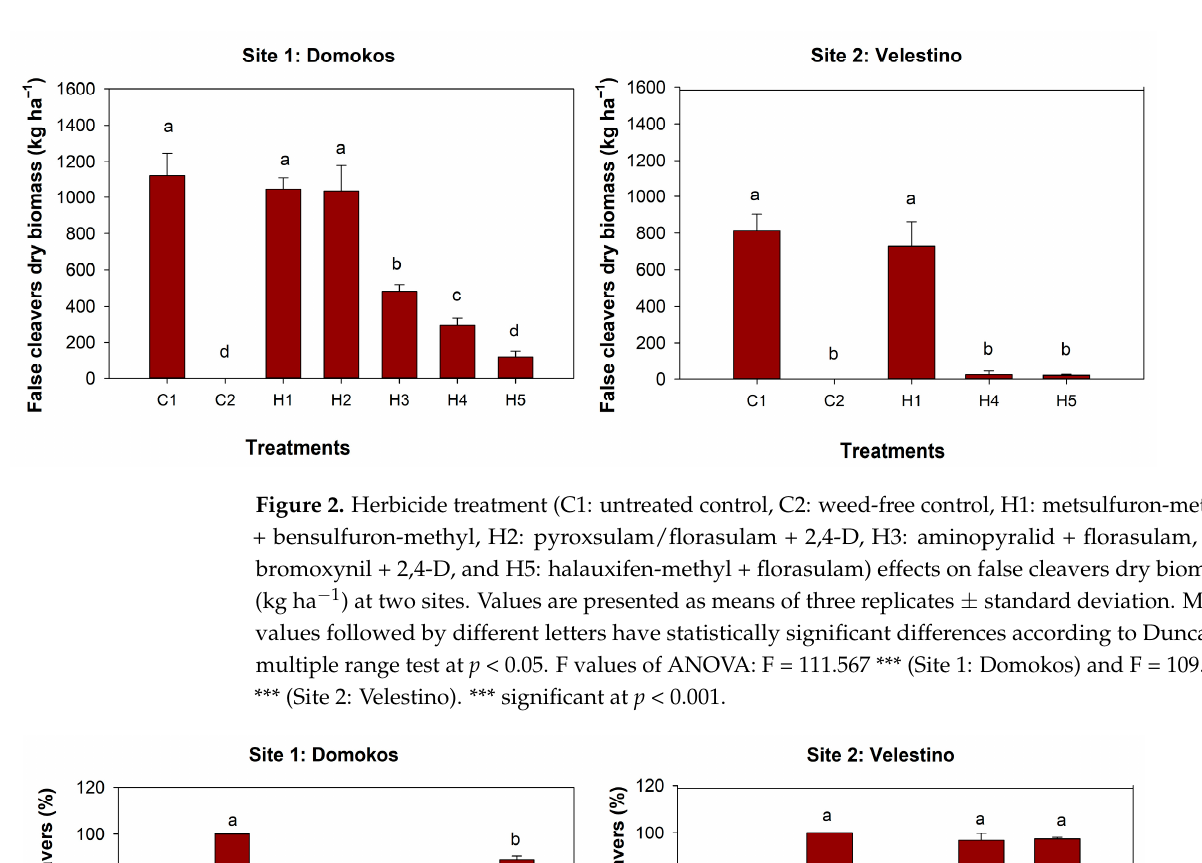
Figure 2. Herbicide treatment (C1: untreated control, C2: weed-free control, H1: metsulfuron-me- thyl + bensulfuron-methyl, H2: pyroxsulam/florasulam + 2,4-D, H3: aminopyralid + florasulam, H4: bromoxynil + 2,4-D, and H5: halauxifen-methyl + florasulam) effects on false cleavers dry biomass (kg ha − 1 ) at two sites. Values are presented as means of three replicates ± standard deviation. Mean values followed by different letters have statistically significant differences according to Duncan’s multiple range test at p < 0.05. F values of ANOVA: F = 111.567 *** (Site 1: Domokos) and F = 109.565 *** (Site 2: Velestino). *** significant at p < 0.001.